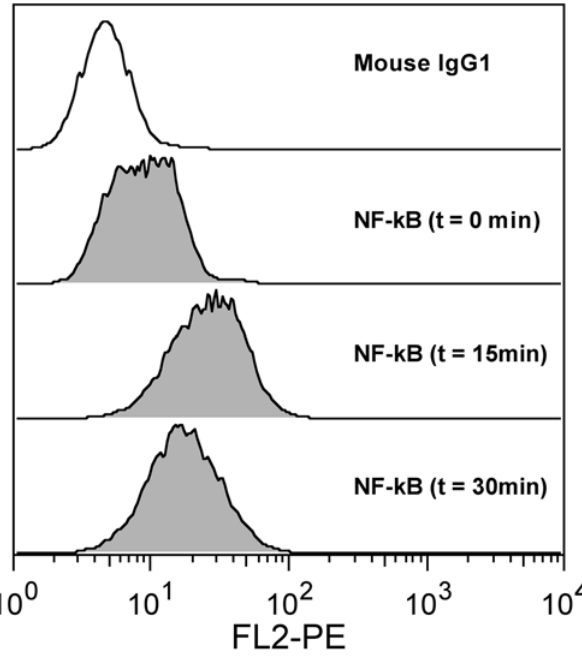
Figure 3. NF- k B activation induced by PSMA crosslinking. LNCaP cells were subjected to stimulation by cross-linking of PSMA or of VCAM-1 for 45 min at room temperature and then cultured for the indicated times at 37 u C. The cells were then harvested, washed, permeabilized and stained with a PE-labelled anti-phosphorylated NF- k B p65 antibody. Cells were then analyzed by flow cytometry. The MFI was recorded. An isotype-matched IgG1 antibody was used to mock- treat LNCaP cells; the Figure illustrates a representative experiment out of three performed independently. MFI values of controls were: untreated cells 9.22 6 0.9, cells treated with an anti-VCAM-1 mAb 5.74 + 0.09, cells treated with a mouse IgG1 mAb 5.02 6 0.3. No substantial differences in the control samples were observed at the various time points of the experiments. MFI of Anti-PSMA cross-linked cells were: 22.03 6 2.2 and 15.6 6 1.3 at 15 min and 30 min, respectively. p values of samples treated with anti-PSMA mAb were , 0.01 at 15 min and 30 min, respectively, with respect to the untreated cells. The first panel from top (mouse IgG1) is the plot corresponding to time 0.